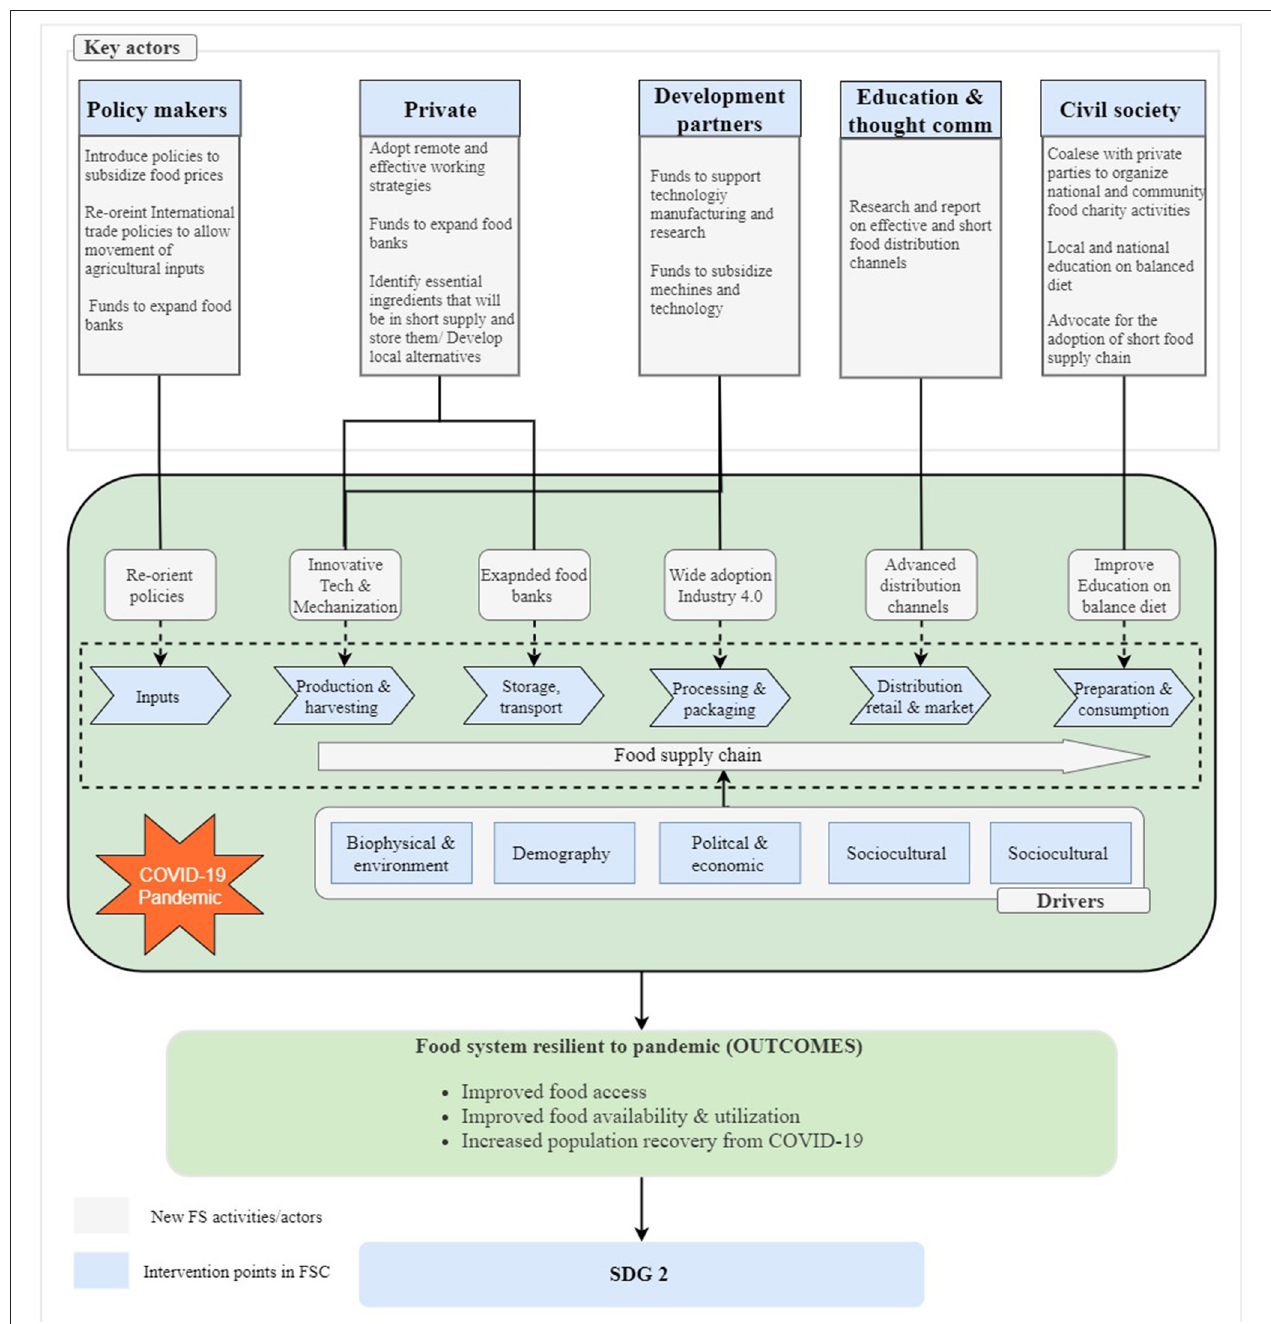
FIGURE 3 | A novel reconstructive framework for building resilience against COVID-19